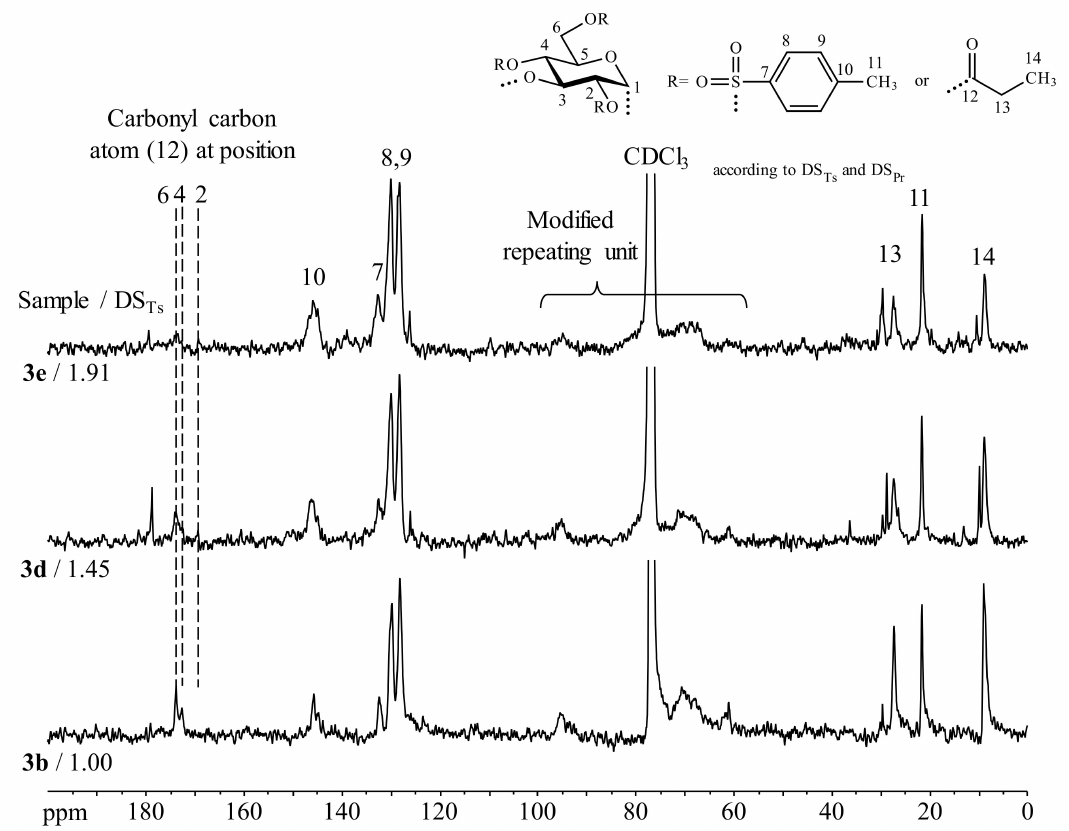
Figure 3. 13 C-NMR spectra of perpropionylated α -1,3-glucan p -toluenesulfonic acid esters of di ff